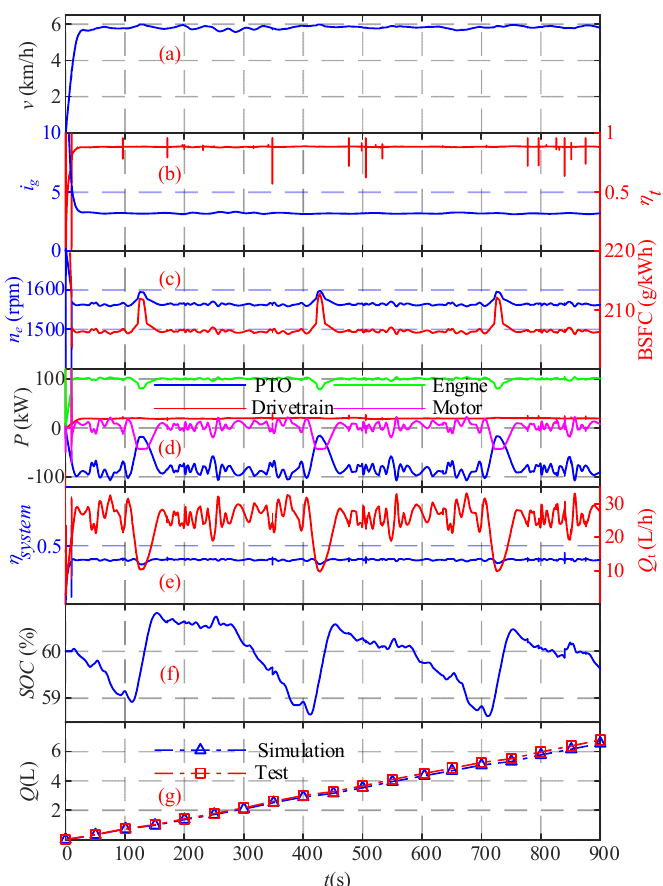
Figure 19. Results of the harvest operation: ( a ) tractor speed, ( b ) transmission ratio and efficiency, ( c ) engine speed and BSFC, ( d ) power of related components, ( e ) system efficiency and instant fuel consumption, ( f ) SOC curve, ( g ) simulation and test fuel consumption.